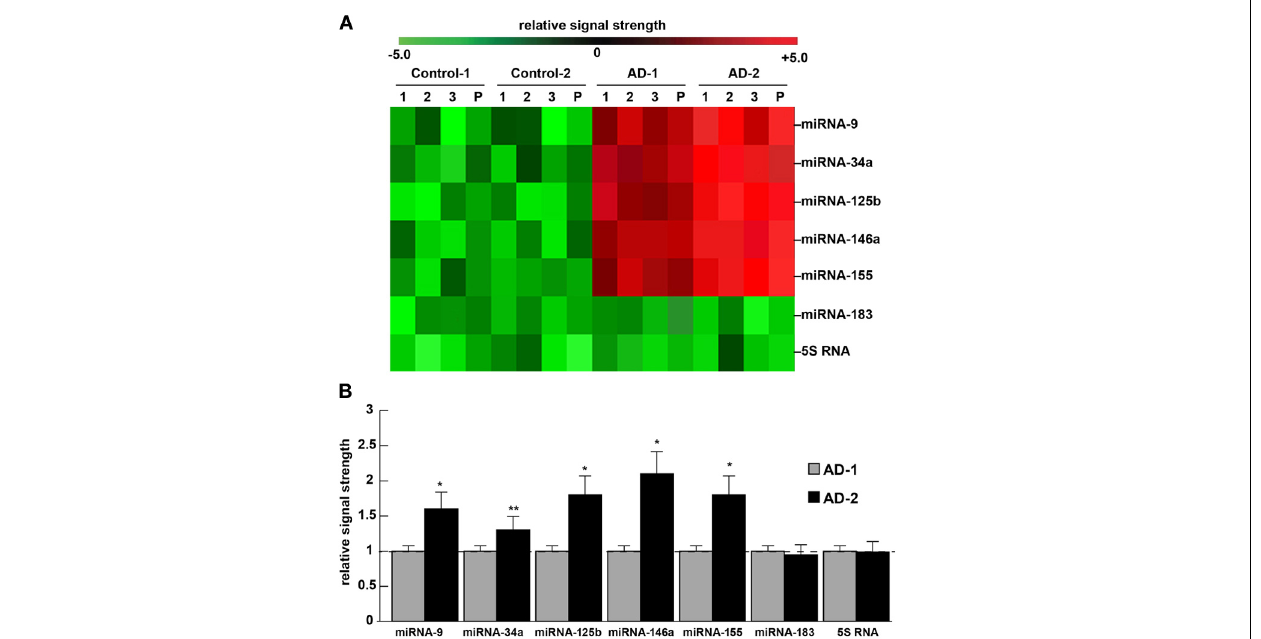
FIGURE 1 | Incidence of miRNA abundance, speciation and complexity for 5 NF-kB-sensitive pro-inflammatory miRNAs in the superior temporal lobe (Brodmann Area A22) of 2 different human populations: The current explosion in miRNA profiling of human disease, including neuro-degenerative diseases such as Alzheimer’s disease (AD), underscores “human genetic individuality.” Preliminary data suggests that there is considerable variation in miRNA abundance, speciation and complexity in human populations, and variation in miRNA abundance amongst individuals or populations may be a reflection of their individual genetic-based susceptibility to disease incidence or severity. (A) depicts a representative color-coded cluster diagram for 2 control and 2 selected “AD” populations; control-1 miRNA signals are derived from Caucasian Americans [age mean ± 1 standard deviation ( SD ) = 75 . 5 ± 8 . 4 year] and control-2 miRNA signals (age mean ± 1 SD = 76 . 1 ± 7 . 8 year) are derived from African Americans; similarly AD-1 miRNA signals are derived from Caucasian Americans [age mean ± 1 SD = 77 . 4 ± 7 . 5 year] with AD, and AD-2 miRNA signals are derived from African Americans (age mean ± 1 SD = 76 . 6 ± 8 . 2 year ) with AD; all AD cases were for moderate-to-advanced stages of AD. Because, as single stranded ribonucleotides, miRNAs appear to have a relatively short half-life, all PMIs had a mean of 2.1h or less (Sethi and Lukiw, 2009; Cui et al., 2010); there were no significant differences in age, PMI, ApoE allele status, RNA quality (all RIN values were 8.1–9.0) or yield between the control or AD groups ( p > 0.05, ANOVA), or between the Caucasian and African American groups; note the higher general expression for miRNA-9, miRNA-34a, miRNA-125b, miRNA-146a and miRNA-155 (a) for